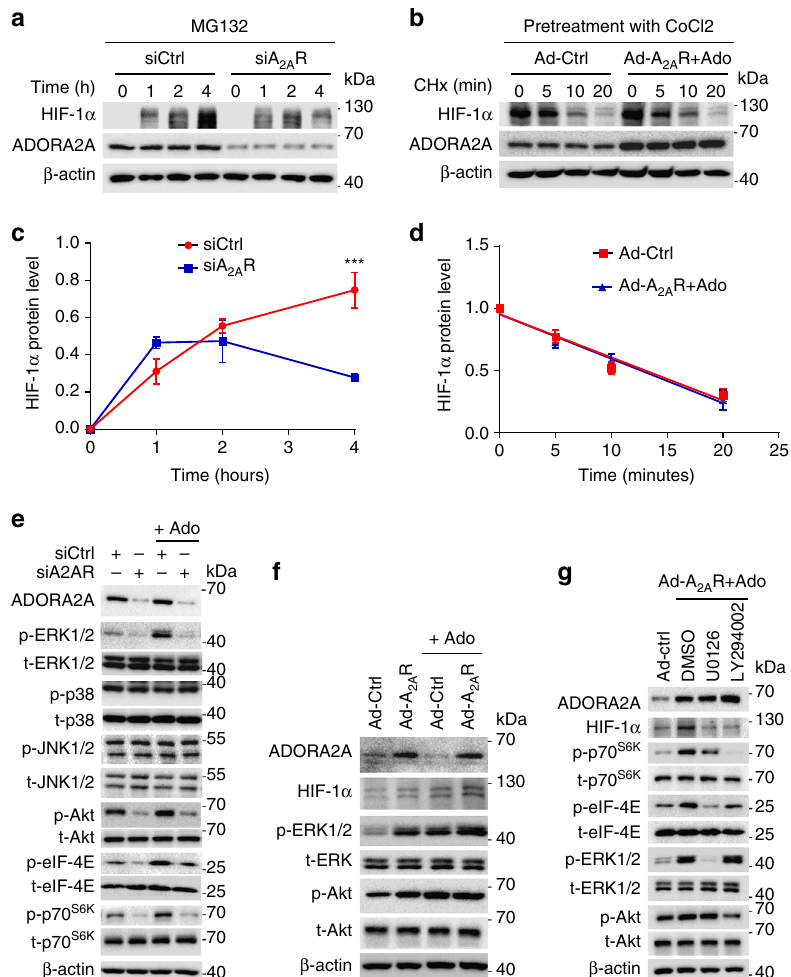
Fig. 9 ADORA2A regulates HIF-1 α protein level through activation of the PI3K/Akt and MEK/ERK-mediated translational machinery. a Western blot analysis of HIF-1 α at protein level in HRMECs. Cells were transfected with siA 2A R or the siCtrl for 48 h, and then treated with MG-132 (10 µ M) for 1, 2 and 4 h. b Western blot analysis of HIF-1 α at protein level in HRMECs. Ad-Ctrl and Ad-A 2A R-infected HRMECs were fi rst treated with CoCl 2 (200 μ M) for 8 h to increase HIF-1 α protein level and then further treated with CHx (50 µ M) for the indicated time periods. c , d The relative protein levels of HIF-1 α were quanti fi ed by comparing the intensities of protein bands at the indicated times to that at time 0. n = 3, *** P < 0.001. Data are represented as means ± s.e.m. Statistical signi fi cance was determined by two-way ANOVA followed by Bonferroni test. e Western blot analysis of the levels of total-ERK (t-ERK), phospho-ERK1/2 (p-ERK1/2), phospho-p38 (p-p38), total-p38 (t-p38), phospho-JNK1/2 (p-JNK1/2), total-JNK1/2 (t-JNK1/2), phospho-p70 S6K (p-p70 S6K ), total-p70 S6K (t-p70 S6K ), phospho-eIF-4E (p-eIF-4E), and total-eIF-4E (t-eIF-4E) in HRMECs transfected with siA 2A R or siCtrl, with or without adenosine treatment under hypoxia. n = 3. f Western blot analysis of HIF-1 α and phosphoproteins in HRMECs infected with Ad-A 2A R, with or without adenosine treatment. n = 3. g Western blot analysis of HIF-1 α and phosphoproteins in HRMECs infected with Ad-Ctrl and Ad-A 2A R in the presence